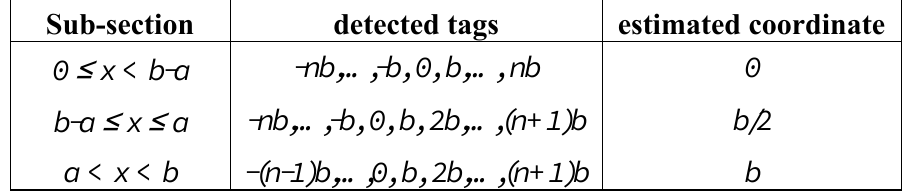
Table 1b. Estimated coordinates from analytical approach ( b/2 ≤ a < b